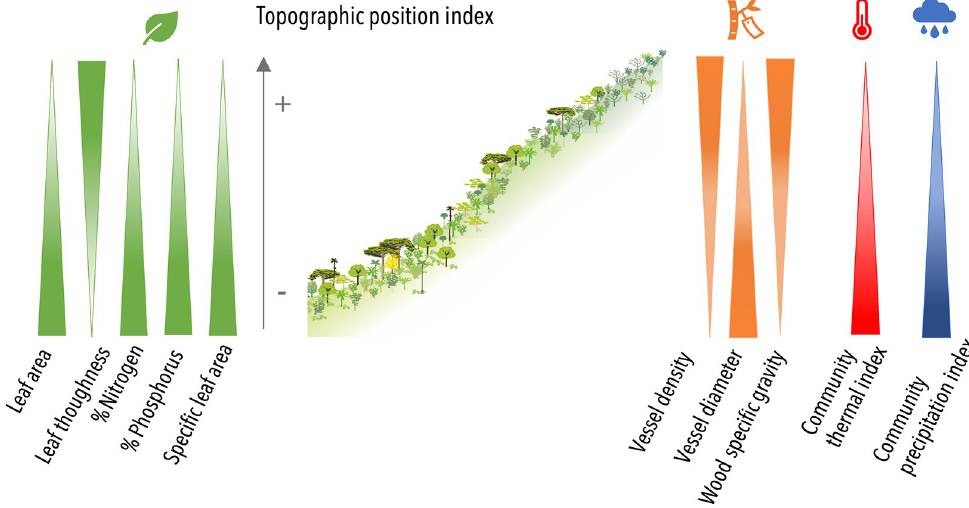
Fig 4. Community Temperature Index (A) and Community Precipitation Index (B) for the plant community along a topographic gradient Topographic Position Index (TPI). Lines indicate statistically significant linear regressions ( P � 0.05) for the first (2008) and last (2016) monitoring year. Each point represents a forest monitoring